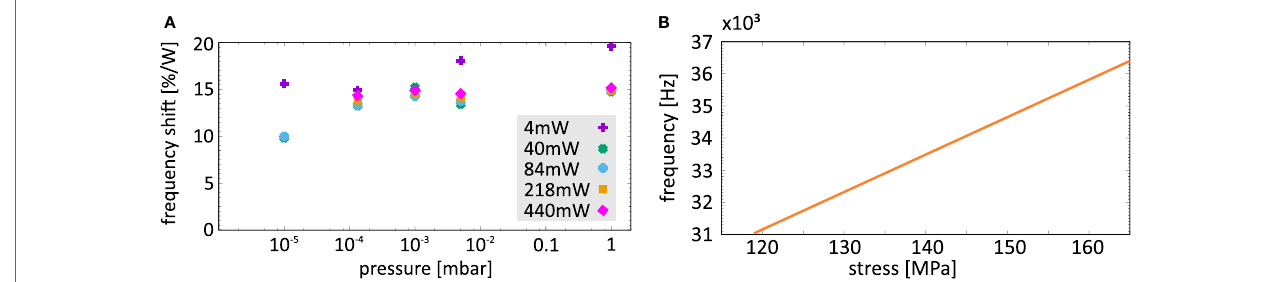
FIGURE 5 | (A) Normalized frequency shift of the 32kHz mode measured at varied pressure. The frequency shift was measured for several different frame heating powers (532nm) and normalized to the power. (B) The relationship between the frequency of the first resonance mode of the membrane and the stress of the membrane simulated with model 2. This is a purely modeled relationship and not a measured dependence.